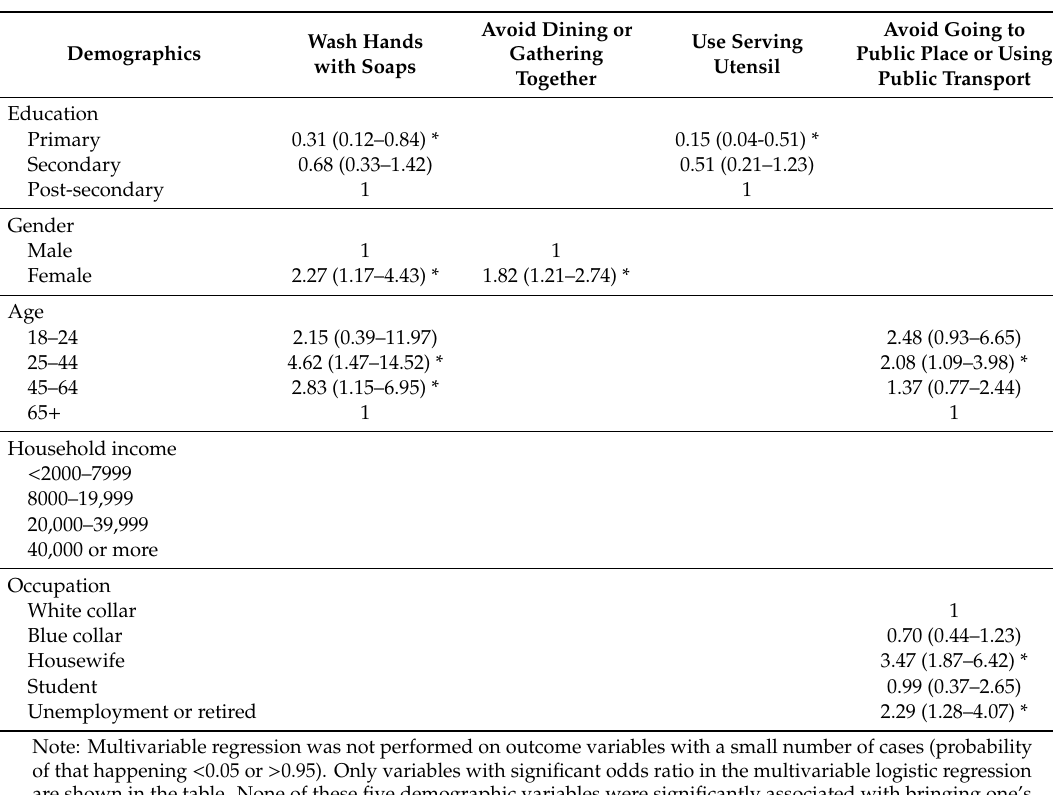
Table A2. Association between demographic variables and the practices (always or usually) of preventive measures against